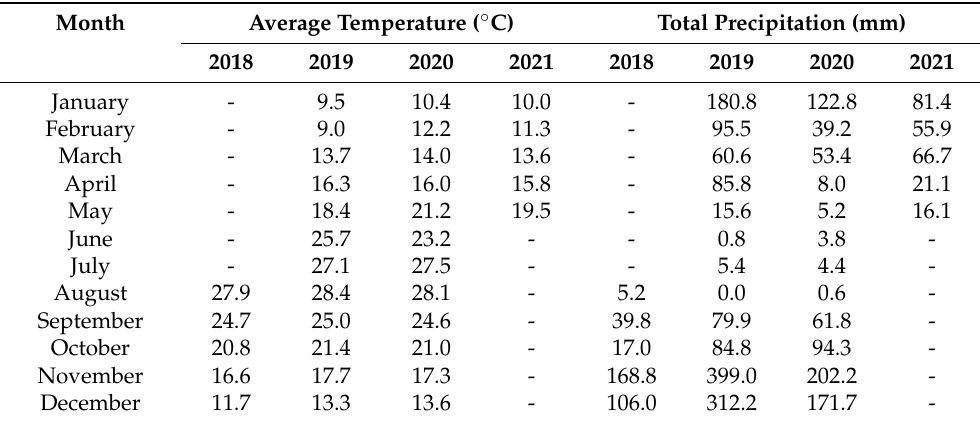
Table 1. Monthly average temperature ( ◦ C) and precipitation height (mm) in the experimental